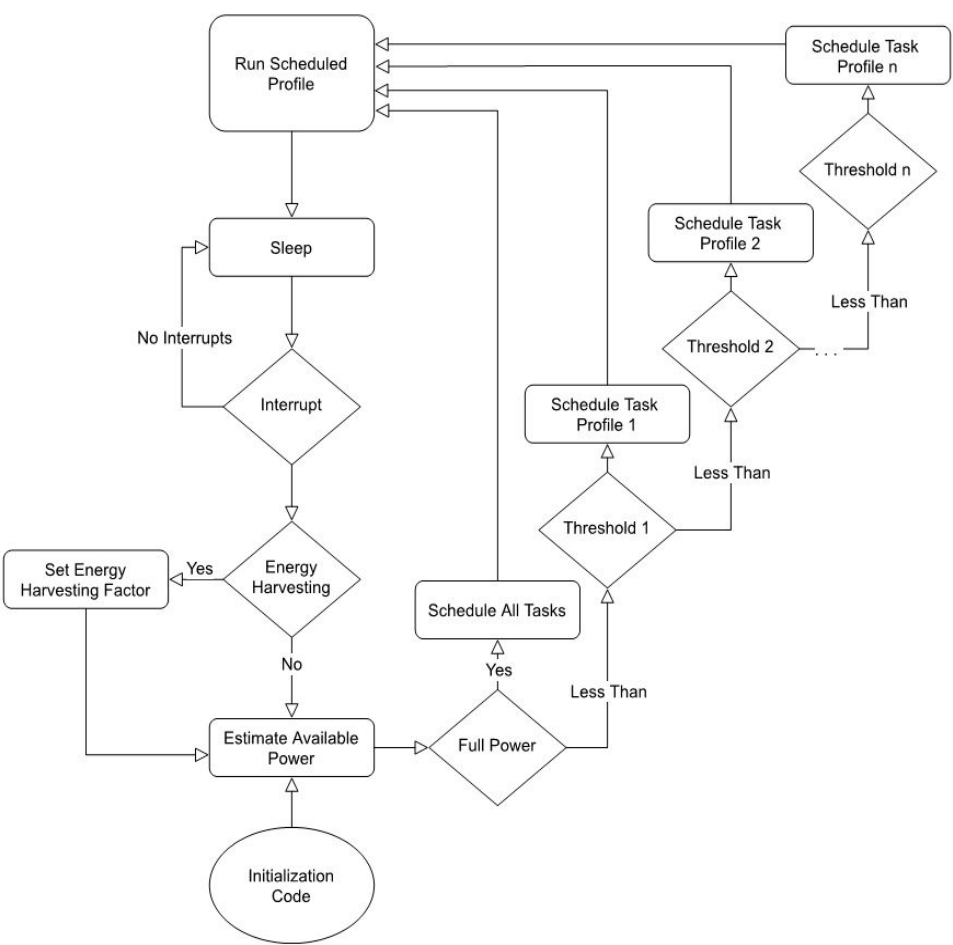
Figure 3. System Power Aware Logic Flow [16].